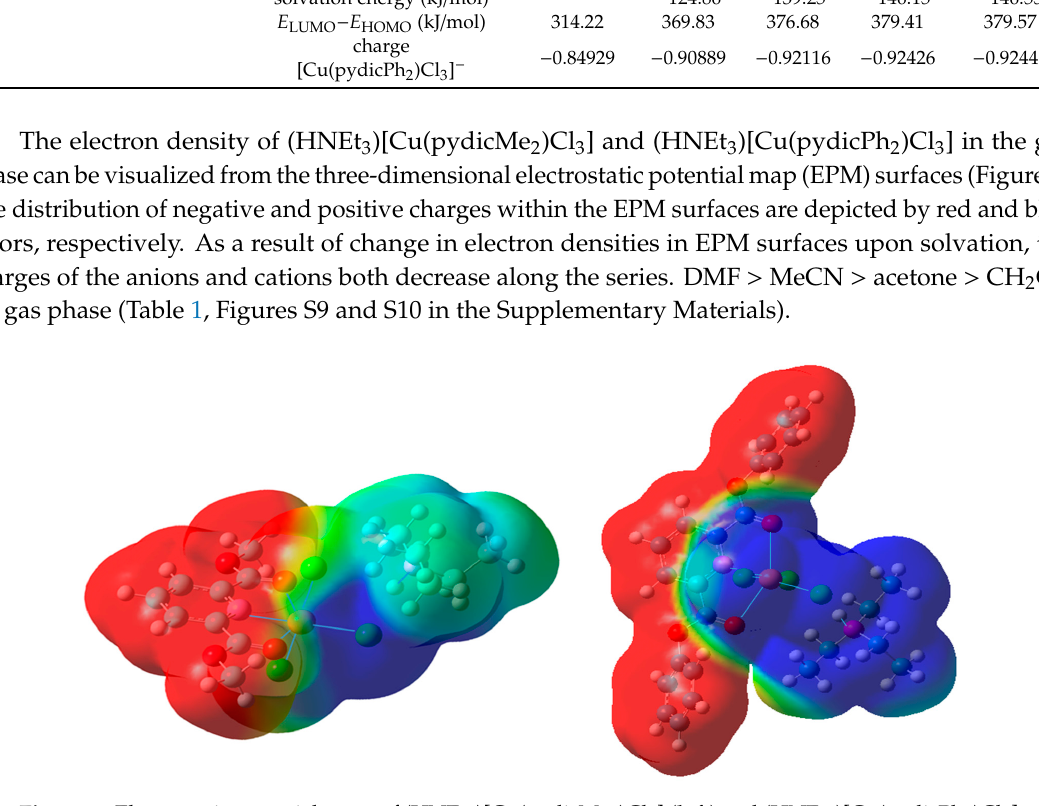
)[Cu(pydicMe )Cl ] ( left ) and 3 2 3